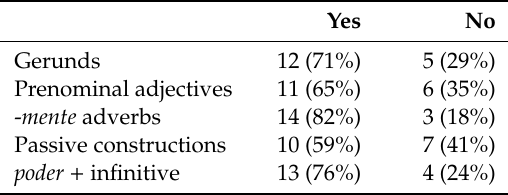
Table 6. Instructors’ responses to whether they deemed the features acceptable ( N =